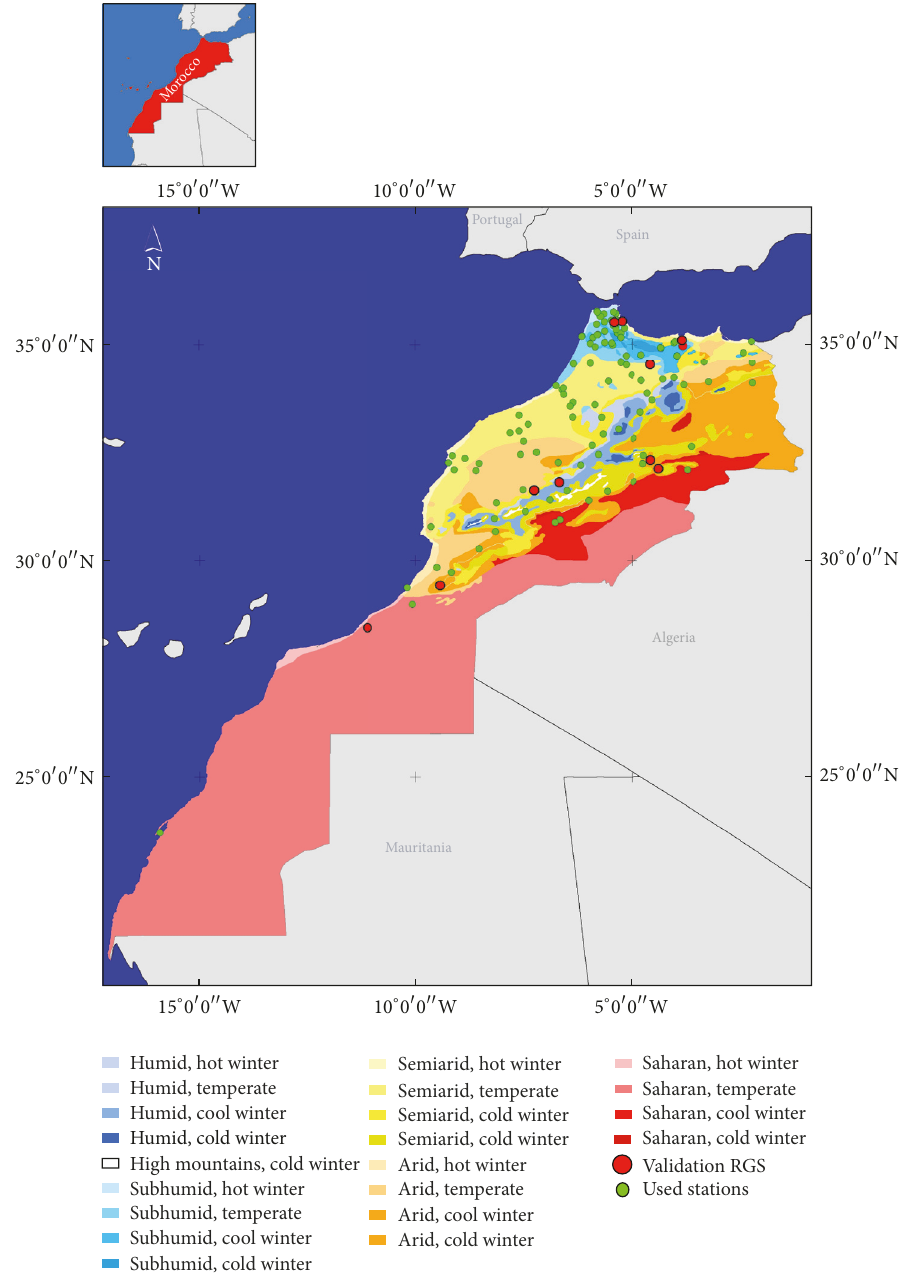
Figure 1: Bioclimatic stages of Morocco according to Emberger’s